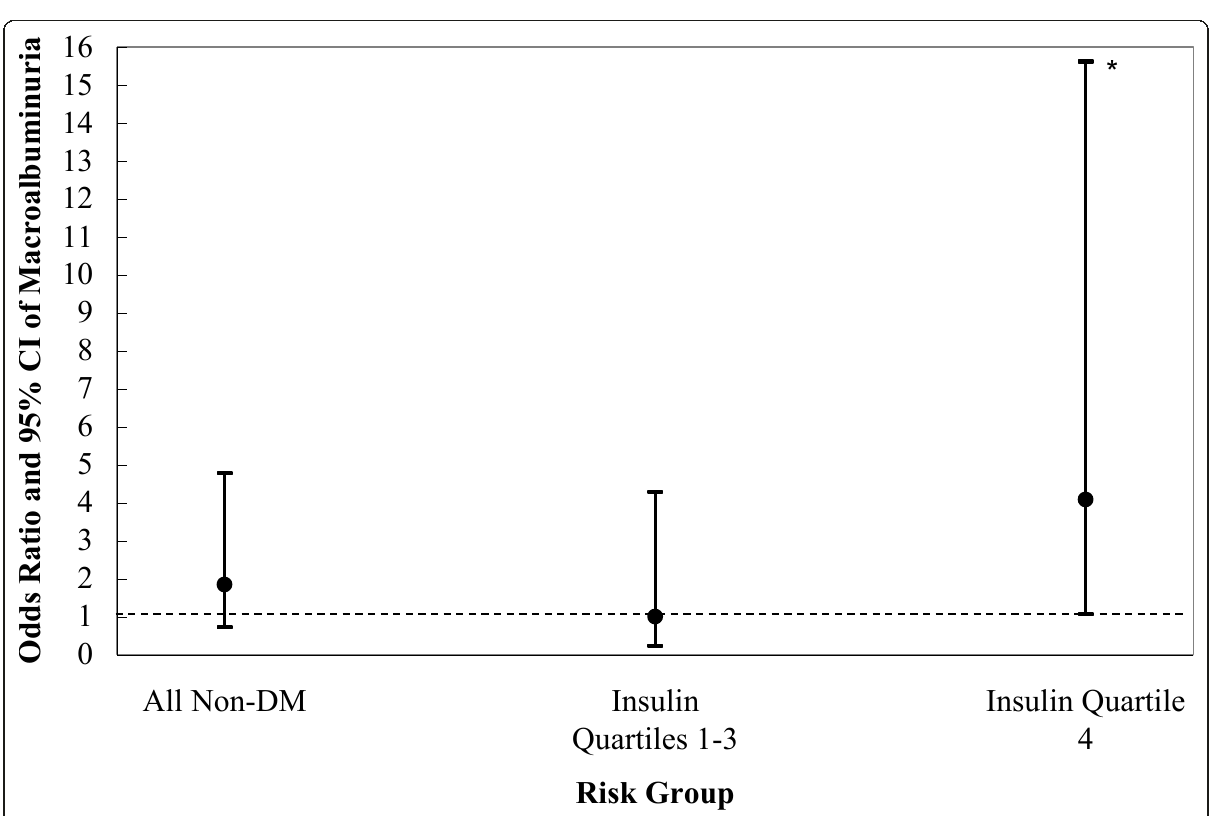
Figure 2 Macroalbuminuria, Enh2 risk genotypes and insulin concentrations among non-diabetic European Americans (n = 6629 (46 cases)) . *P < 0.05. Among non-diabetic European Americans with fasting insulin, the risk of macroalbuminuria associated with the GLUT1 Enh2 TT risk genotype was 1.84, 95% CI: 0.71 - 4.77, P = 0.210, adjusting for age, gender, hypertension status, BMI, and GFR. For individuals in